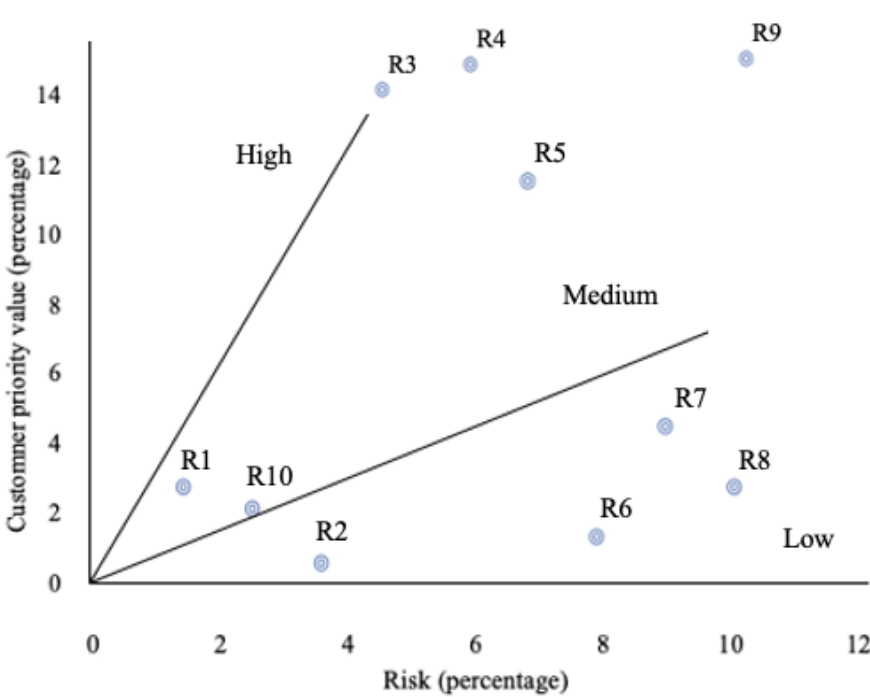
Figure 2. Risk–Customer priority value diagram presenting relationship for project data. R1–R9 are Figure 2. Risk – Customer priority value diagram presenting relationship for project data. R1 – R9 the software are the software requirements